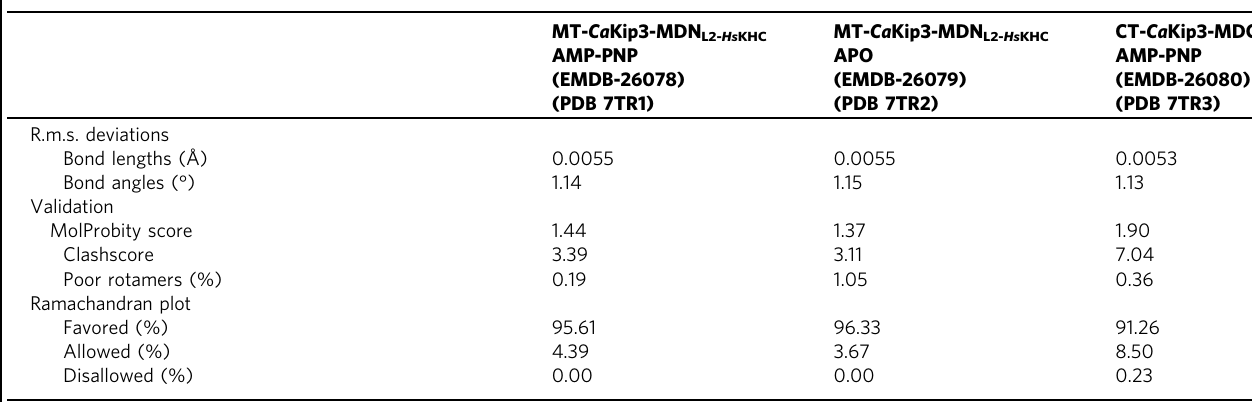
(Fig. 3c, d; left panels). This section interacts with helix-12 and a loop between helix-7 and the β 7 strand of α -tubulin via residues Phe136, Ser139, Arg140, and one of the two visible conformations of the side chain of His144 (Fig. 3c, d; right panels). These loop-2- tubulin interactions are more numerous than the loop-2 contacts made by kinesin-13s 24 , which are essential for kinesin-13 ’ s microtubule depolymerization activity 24,26,27,47 – 49 . Several of the Ca Kip3 loop-2-tubulin helix-12 interactions are electrostatic. For